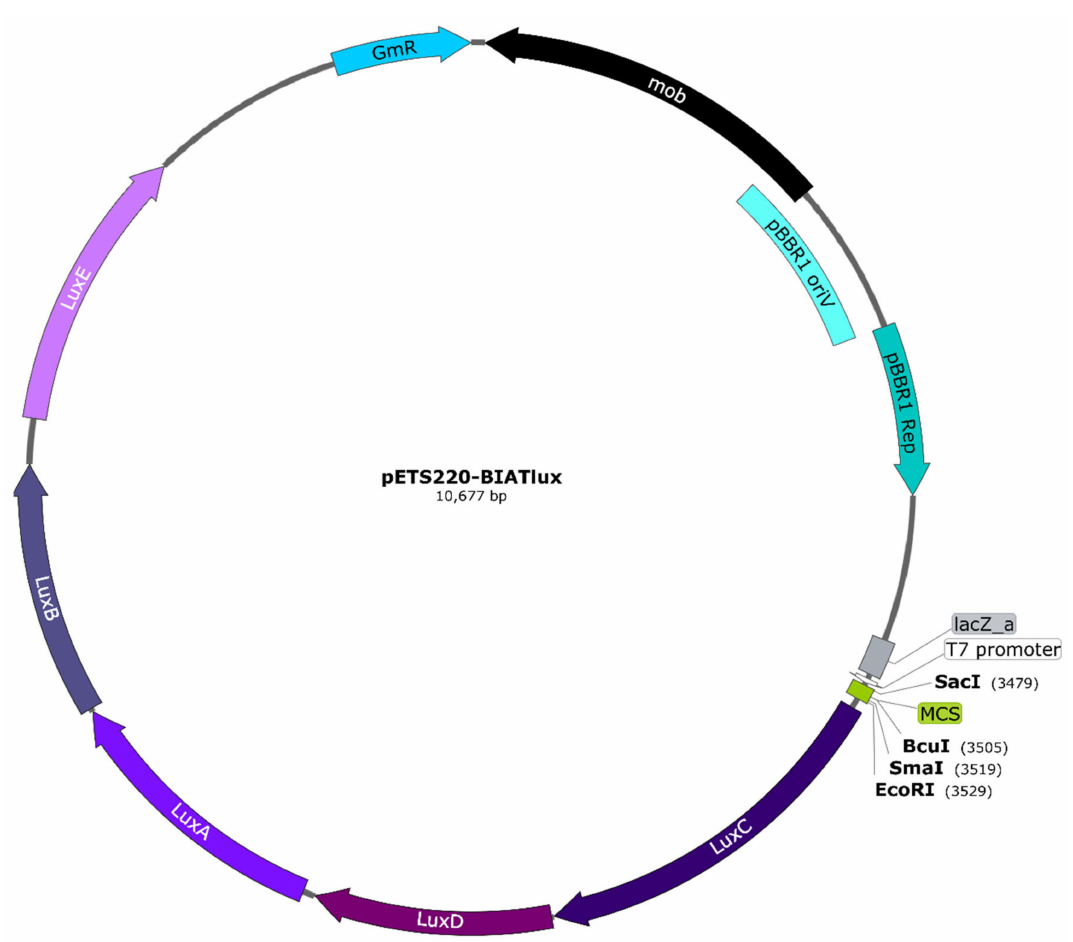
Figure 3. Map of the pETS220-BIATlux (pETSlux) promoter-probe vector. The luxCDABE genes were inserted into the backbone of the pETS130 vector. Relevant genetic elements include: gentamicin resistance (Gm R ) imparted by aacC1 , plasmid mobilization functions encoded by mob, and pBBR1 oriV and pBBR1 Rep as the replication origin and replication protein, respectively, that are essential for broad-host-range capability. Unique cutter restriction enzymes within the multi-cloning site (MCS) are shown in bold. All genes are represented in scale according to the total length of the